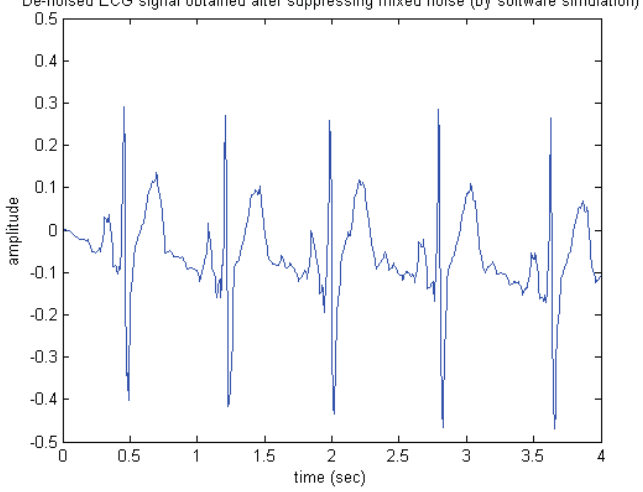
Figure 14. De-noised ECG signal obtained after suppressing mixed noise (by software simulation).